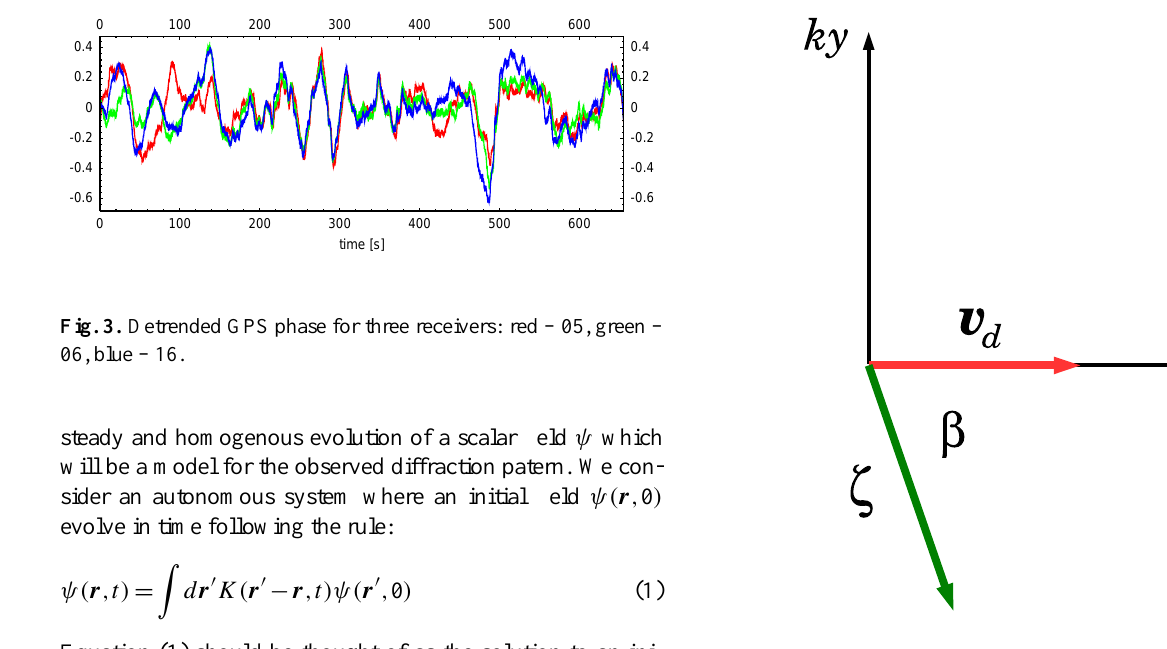
Fig. 4. Reference frame used in Eq.